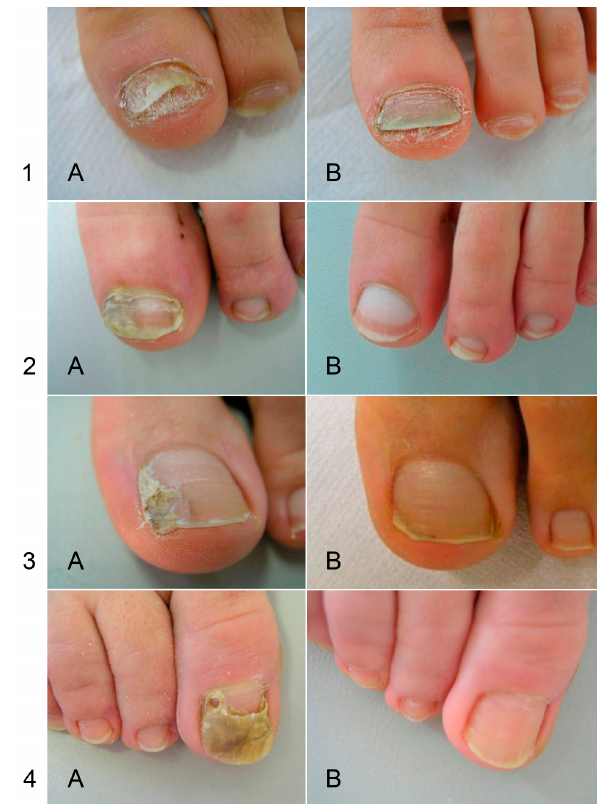
Figure 2. Efficacy of treatment with amphotericin B in topical application for NDM onychomycoses. ( A ) before treatment; ( B ) after treatment. The infectious agent identified by PCR was Fusarium sp. in patients 1 and 2, and Aspergillus oryzae in patients 3 and 4. Figure from Monod et al., Rev Med Suisse. 2013, 380:730-3, with permission of the